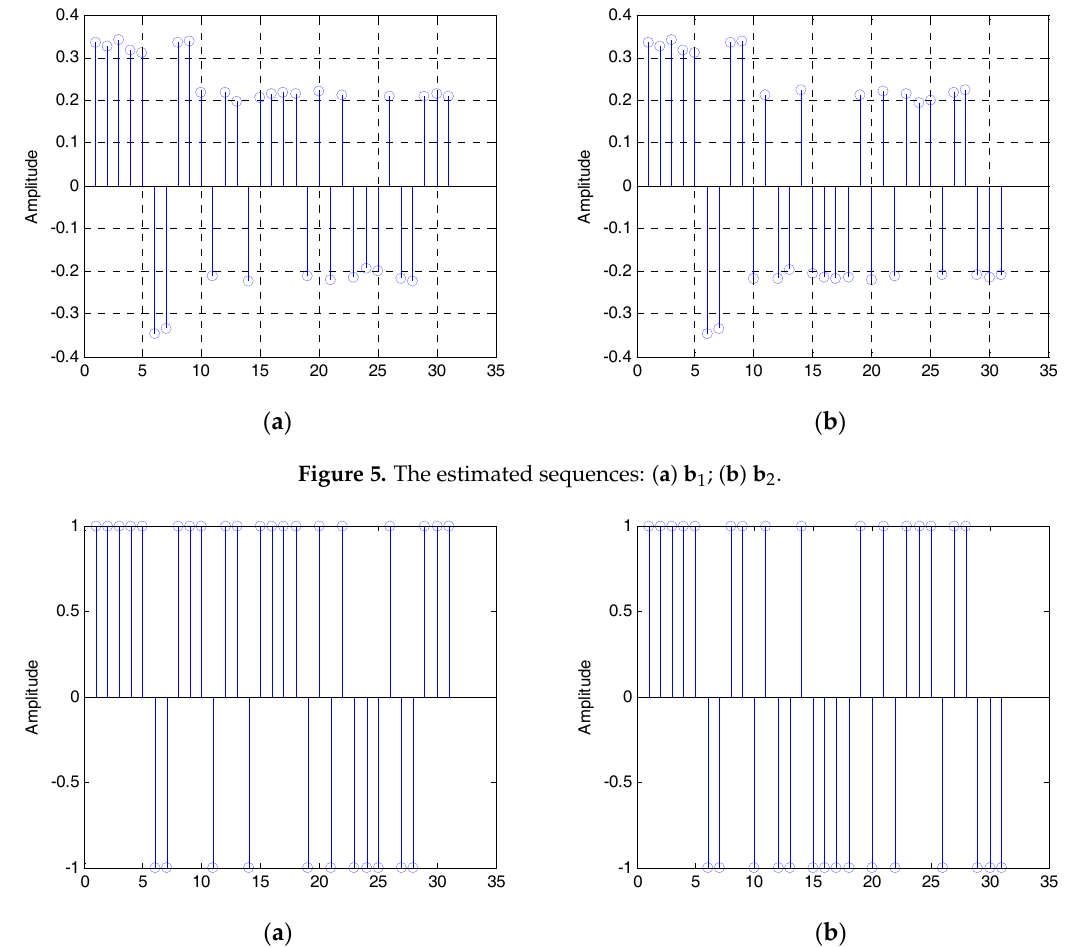
Figure 7. Number of iterations for network convergence of the original LEAP and the modified LEAP sunder different SNRs.